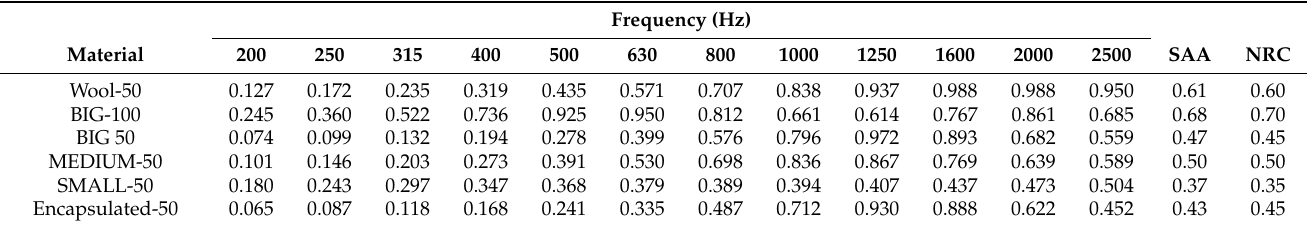
Table 2. Sound absorption coefficients for the twelve one-third octave bands from 200 to 2500 Hz of the tested materials and the respective noise reduction coefficient ( NRC ) and sound absorption average ( SAA